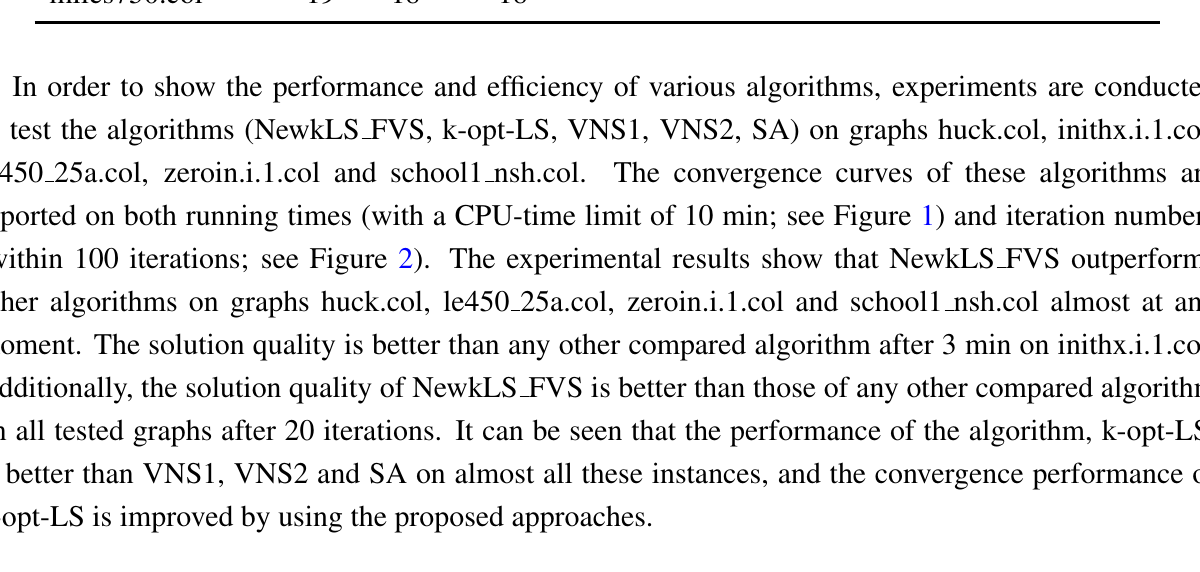
Figure 1. Comparison of the algorithms with a CPU-time limit of 10 min. ( a )